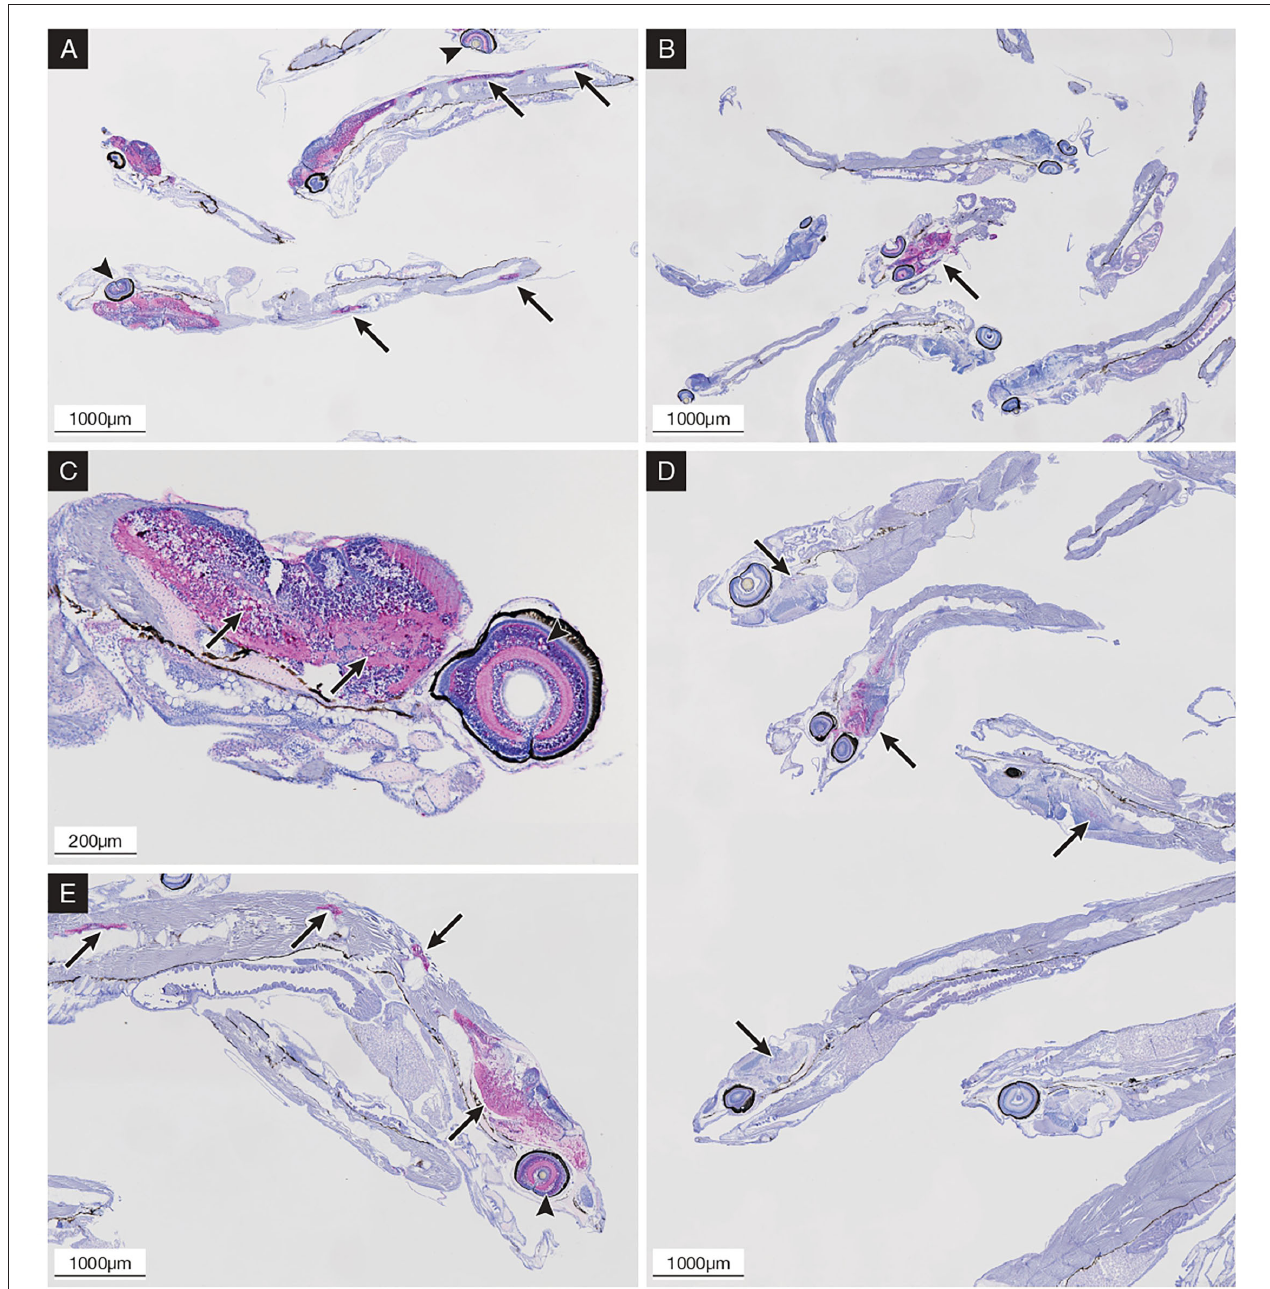
FIGURE 6 | Immunohistochemical (IHC) staining of sea bass larvae challenged via the oral route (B,D,E) and by bath (A,C) at different time points; the presence of betanodavirus antigens was revealed in bright red color. (A) 9 dpi; bath challenged larvae showing diffuse central nervous system (CNS) and retina (arrowheads) IHC staining and CNS vacuolization; positive spinal cord highlighted with arrows. (B) 9 dpi; orally infected larvae showing single positive specimens with intense IHC staining in the CNS (arrow) and retina. (C) 10 dpi; bath challenged larvae showing diffuse IHC staining and vacuolization in the encephalon (arrows) and retina (arrowhead). (D) 17 dpi; orally infected larvae showing positive specimens with variable intensity of IHC staining in the encephalon (arrows). (E) 21 dpi; orally infected larvae showing diffuse IHC staining and vacuolization in the encephalon, spinal cord (arrows), and retina (arrowhead).